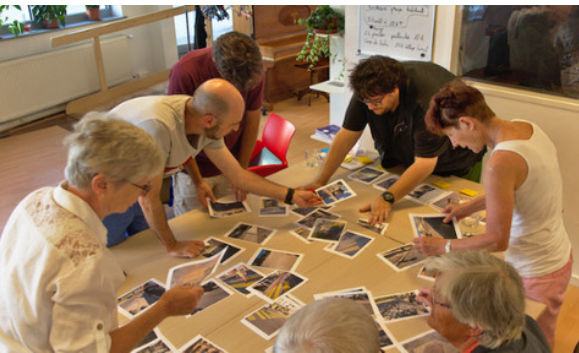
Figure 3. Workshop with senior citizens from